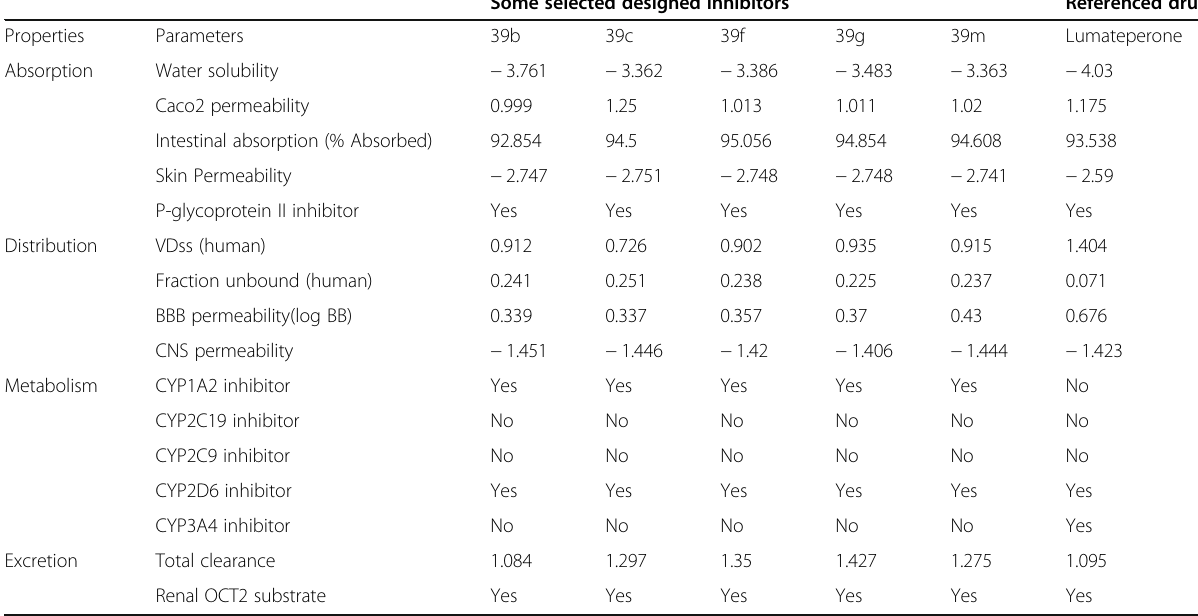
Table 3 Predicted ADME/pharmacokinetics properties of some designed